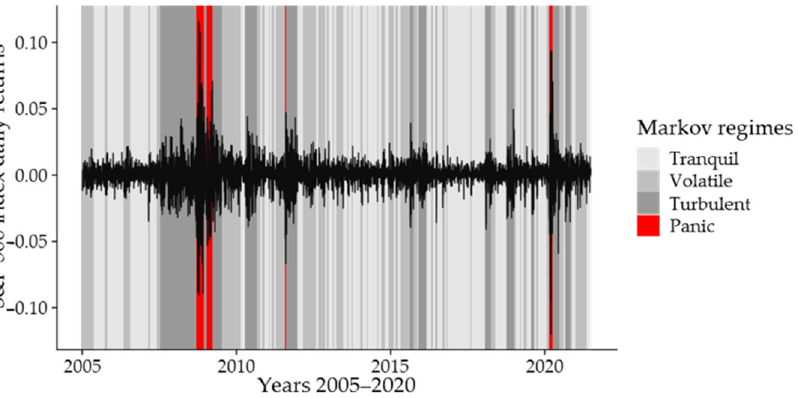
Table 10. Percentage of time spent by the S&P 500 index in each regime.